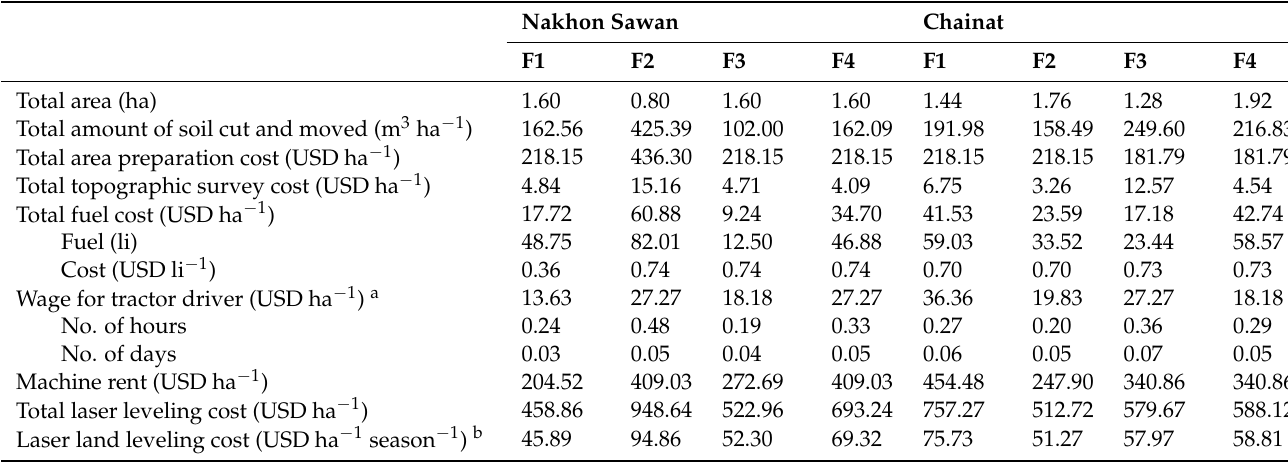
Table A1. Breakdown of laser land leveling cost per farmer’s field in Nakhon Sawan and Chainat provinces, Central